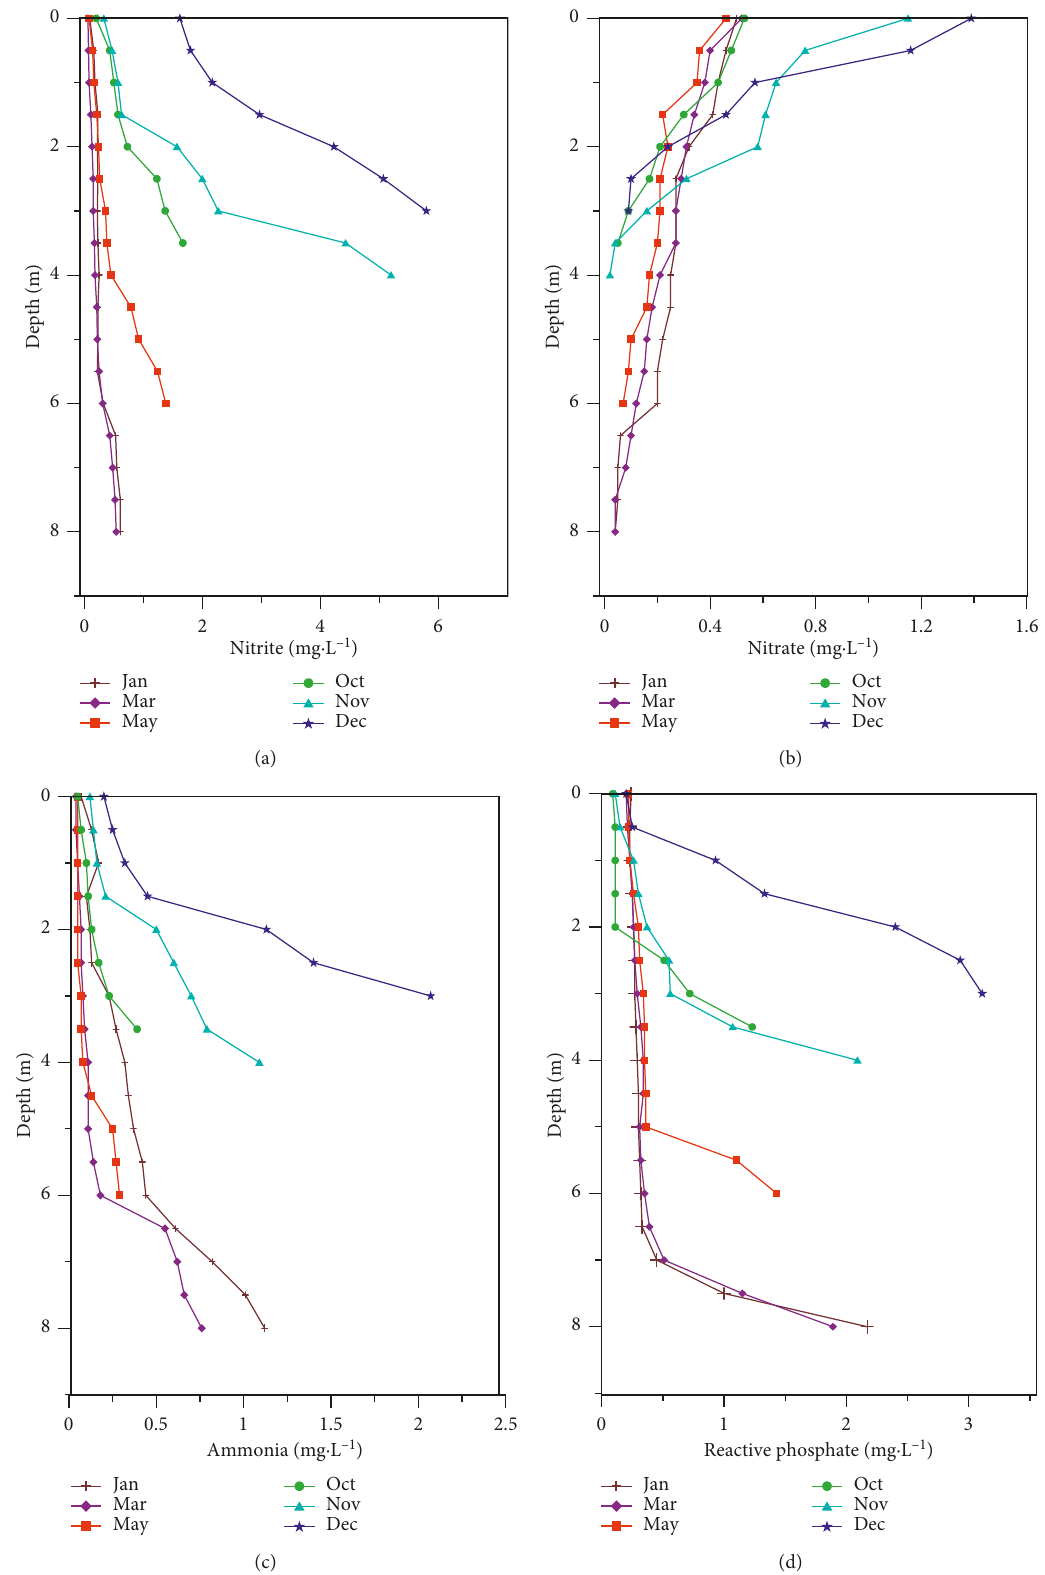
Figure 5: Vertical concentration profiles of nitrite, nitrate, ammonia, and reactive